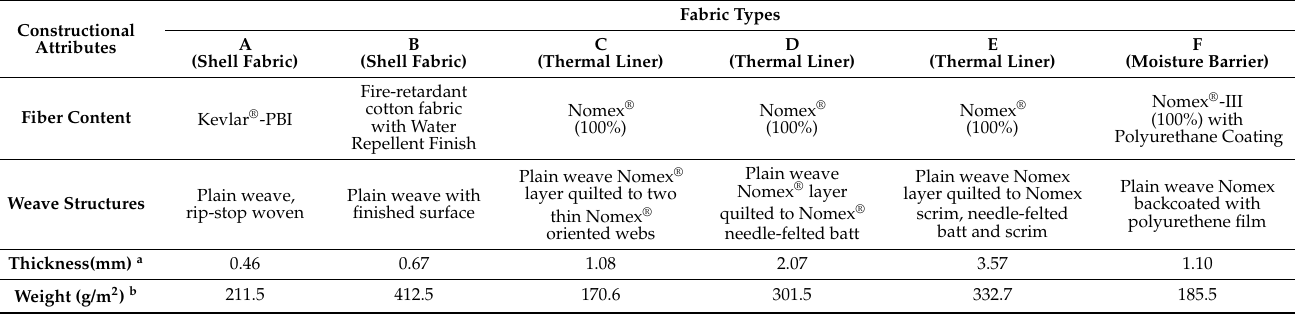
Table 1. Thermal protective fabrics.